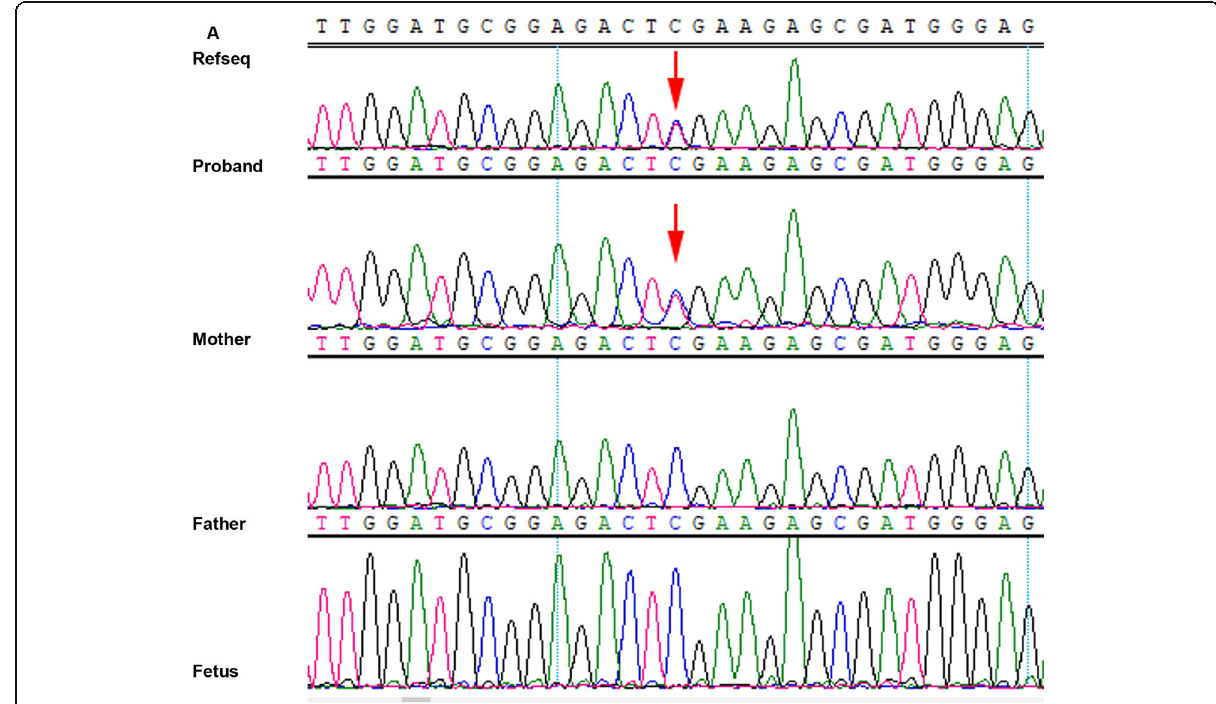
Fig. 1 The nonsense mutation detected in the family using Sanger sequencing. The proband and his mother are heterozygous, while the father and the fetus are the same as the reference sequence. Arrow indicates mutation site